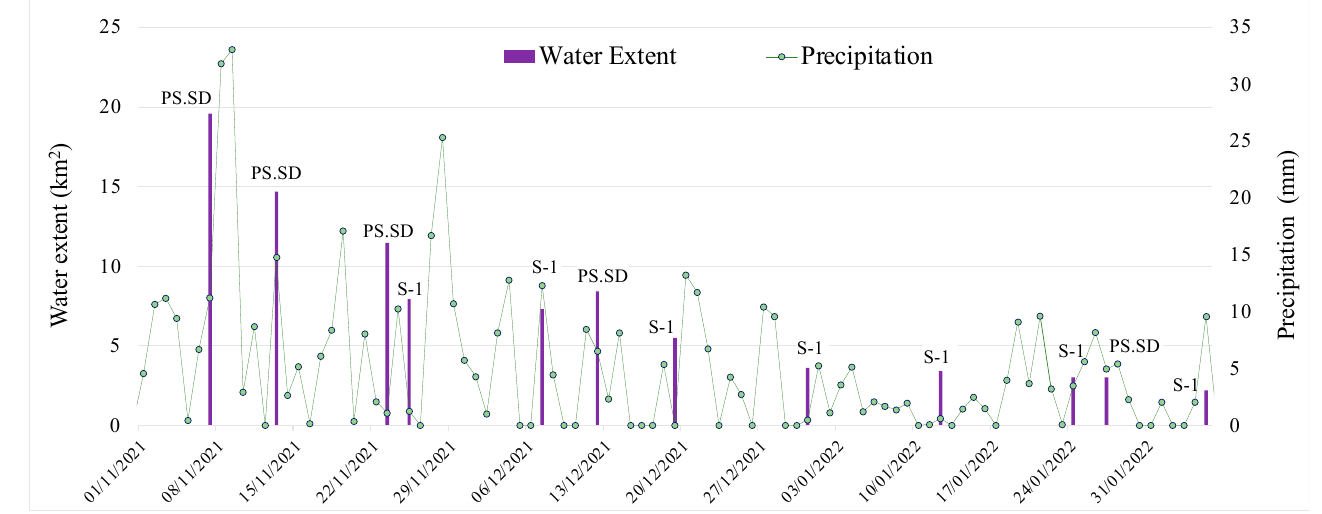
10 of 16 Figure 6. Landcover transformations and water areas using PlanetScope’s SuperDove and Sentinel- 1 series: ( a , e , f , h – k ) and ( m ) water extents extracted from the Sentinel-1 datasets using the Otsu thresholding algorithm; ( b – d , g , l ) landcover classification using PlanetScope’s SuperDove datasets; and ( n ) ESA 2020 landcover.